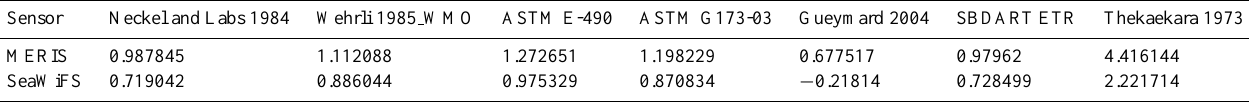
Table 5. The band-averaged percent differences with the Thuillier 2004 spectrum.